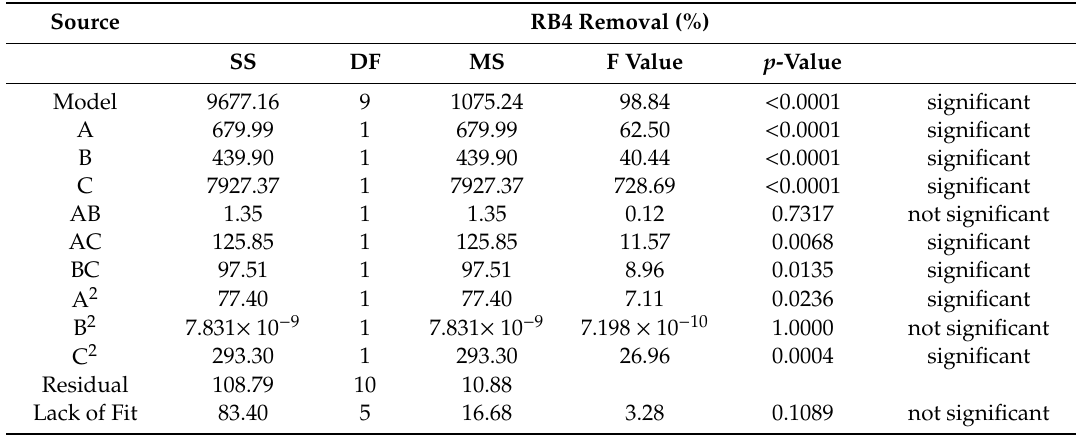
Table 6. Analysis of variance (ANOVA) for the empirical